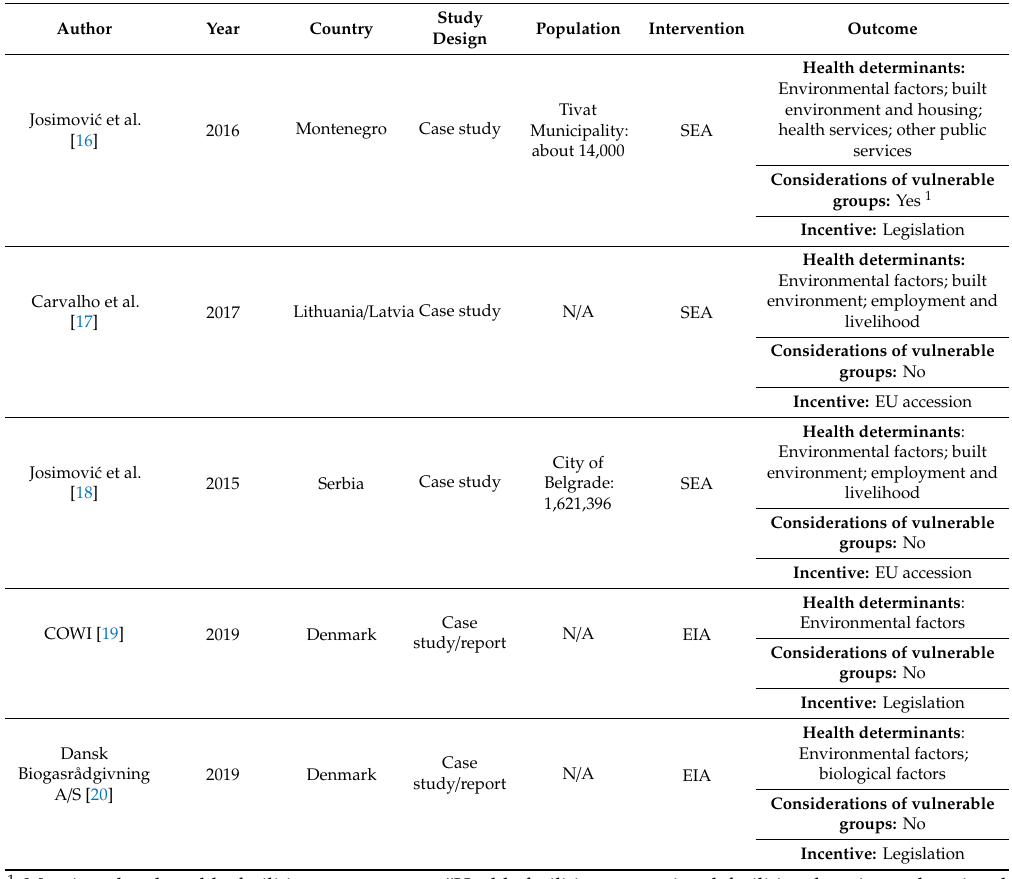
Table 3. Comparison of reviewed